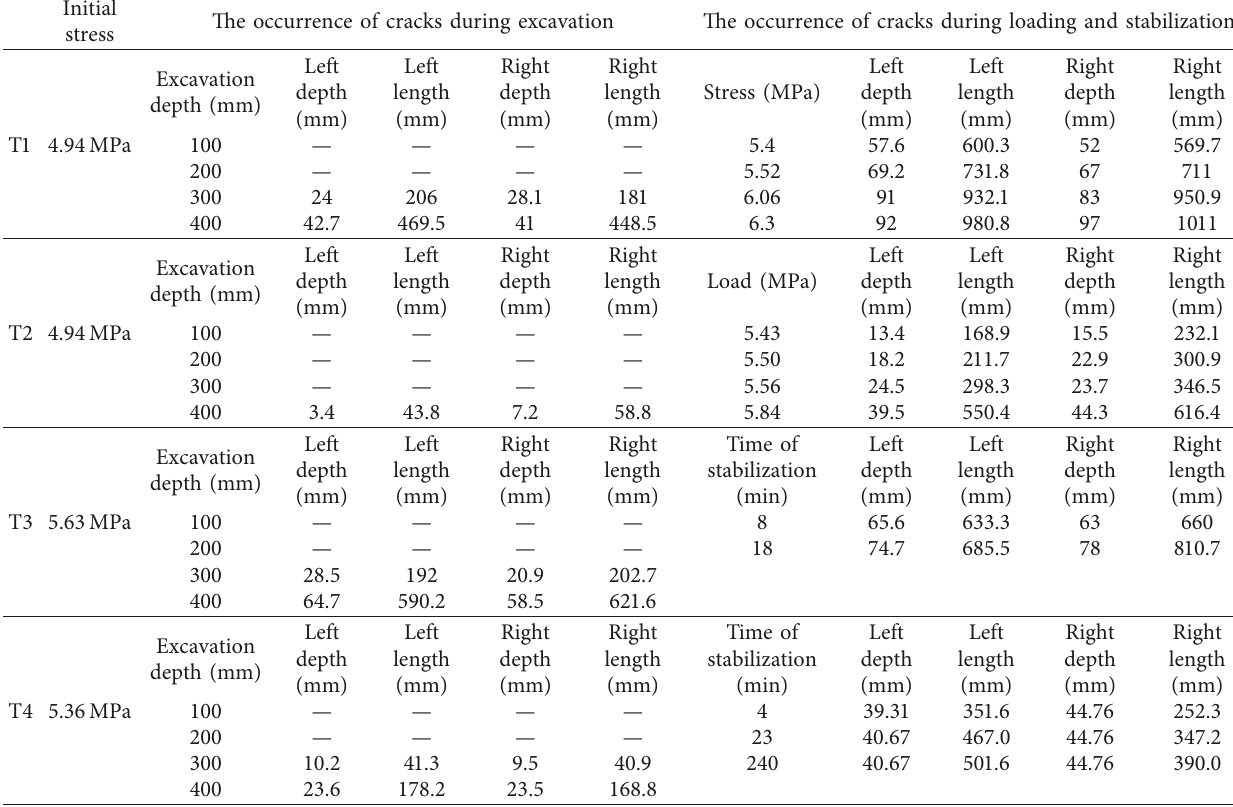
Table 4: The depth and total length of cracks during tunnel excavation, loading, and stabilization. Initial